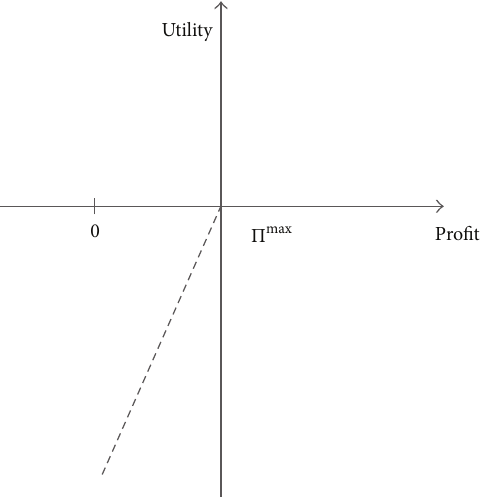
Figure 1: Loss aversion function. Figure 2: Loss aversion function when Π 0 = Π max